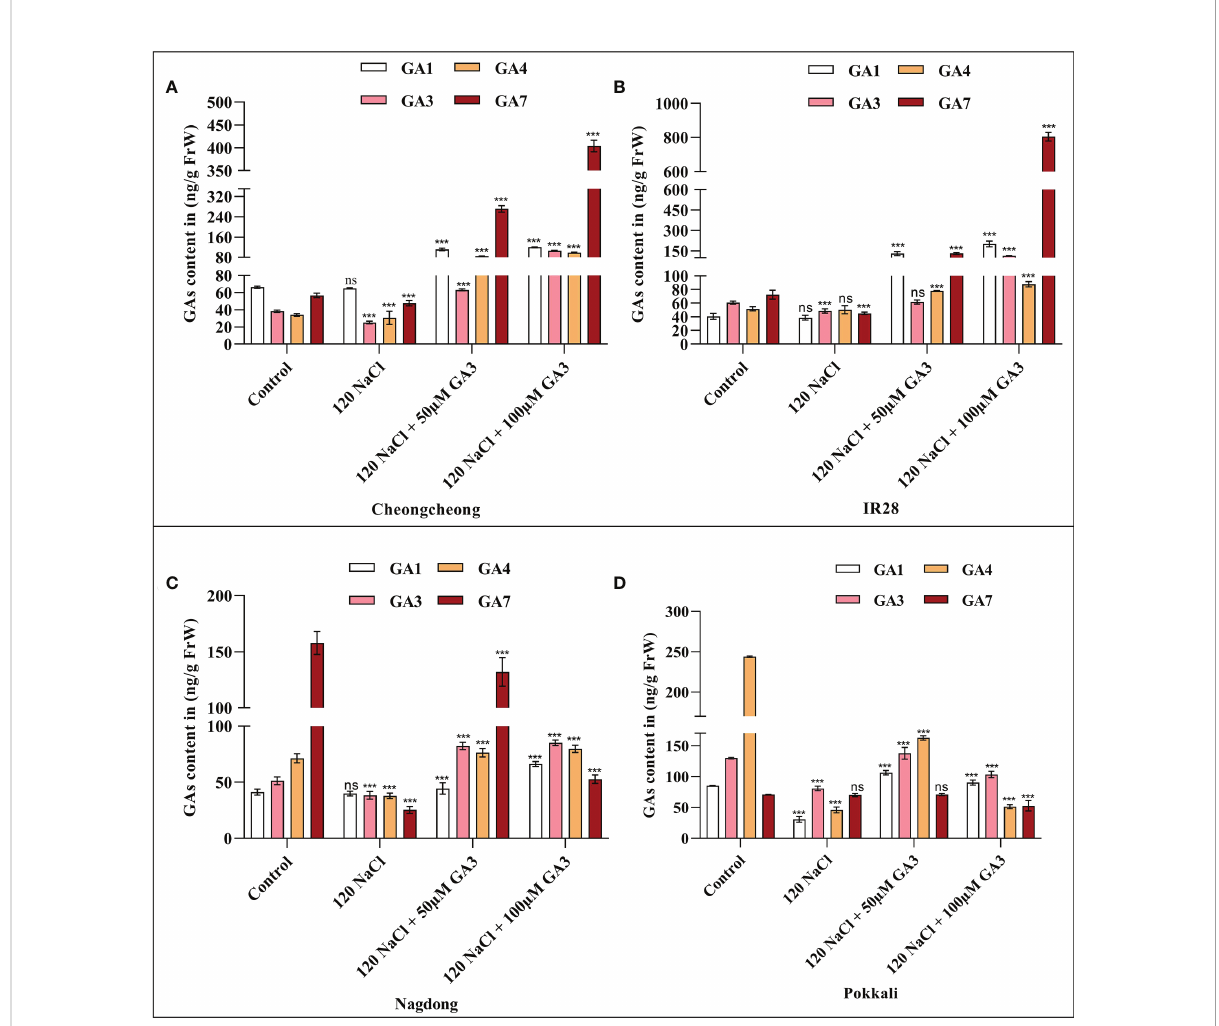
FIGURE 3 GA quanti fi cation in 14-day old rice ( Oryza sativa L.) seedlings, treated with distilled water (control), 120 mM NaCl, 120 mM NaCl + 50 µM GA3, or 120 mM NaCl + 100 µM GA3 (A – D) . Group differences were analysed by two-way ANOVA. Asterisks indicate a signi fi cant difference compared to the control group, as analysed by Tukey ’ s multiple comparisons test. *** P < 0.00; ns, not signi fi cant. GA, gibberellin; GA1, gibberellin A1; GA3, gibberellic acid; GA4, gibberellin A4; GA7, gibberellin